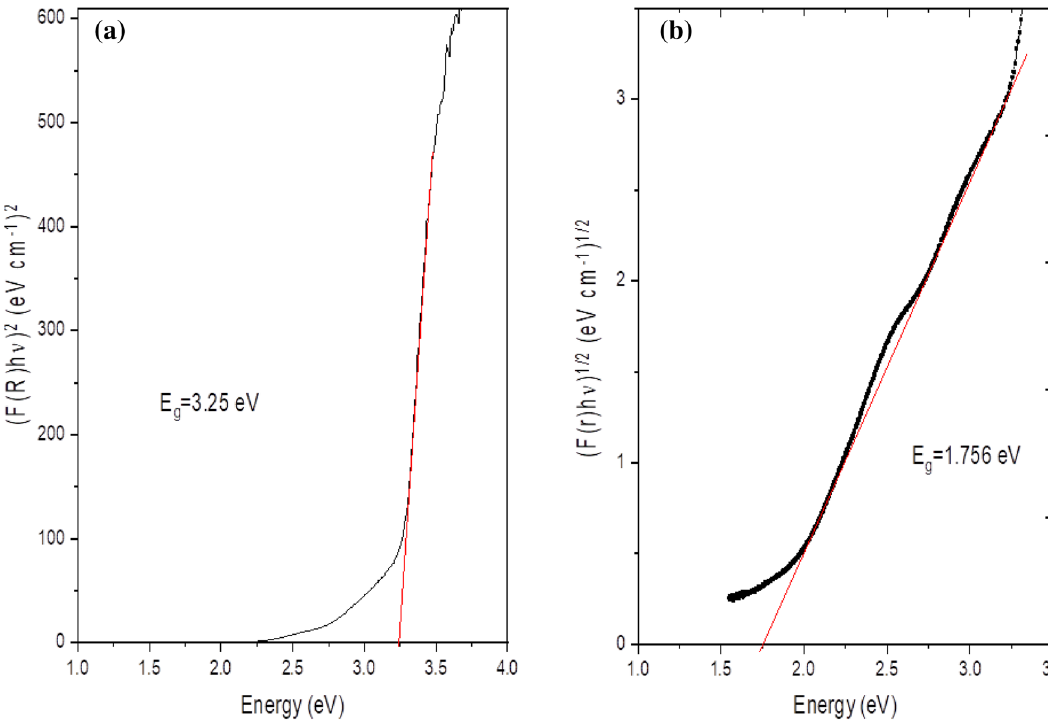
Figure 5. Tauc plot showing a possible fit to obtain the bandgap for Zn–Fe LDH with ( a ) direct and ( b ) indirect transitions.